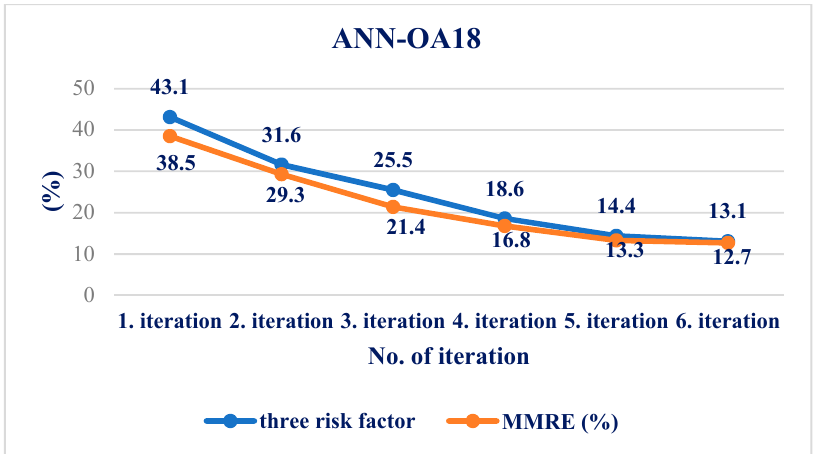
Figure 6. Influence of three factors on the resulting risk and error of the ANN-OA18 model through six iterations.